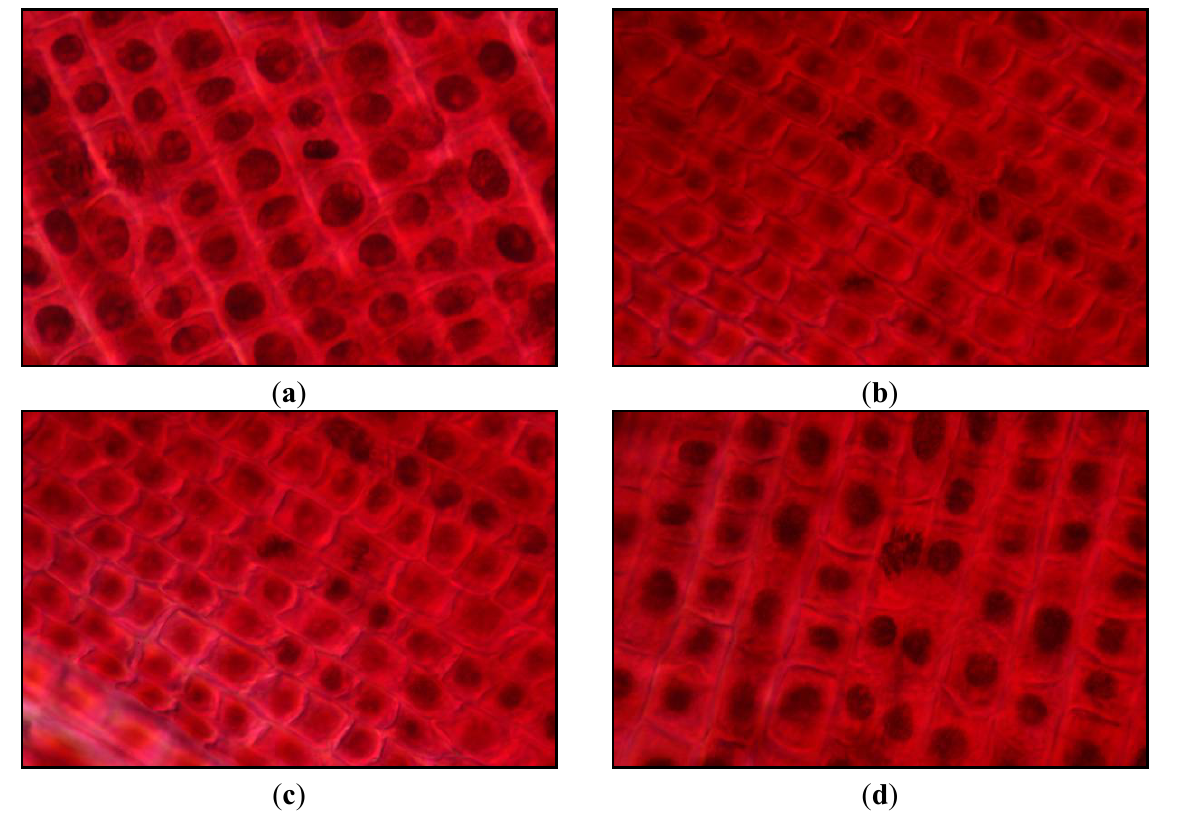
Figure 5. Kariokinetic film modifications observed in Triticum test: ( a ) polyploid telophase induced by colchicine at 0.1 µmol/L; ( b ) metaphase in tropokinesis and anaphase with late chromosomes induced by 4b at 1 µmol/L; ( c ) metaphase in tropokinesis